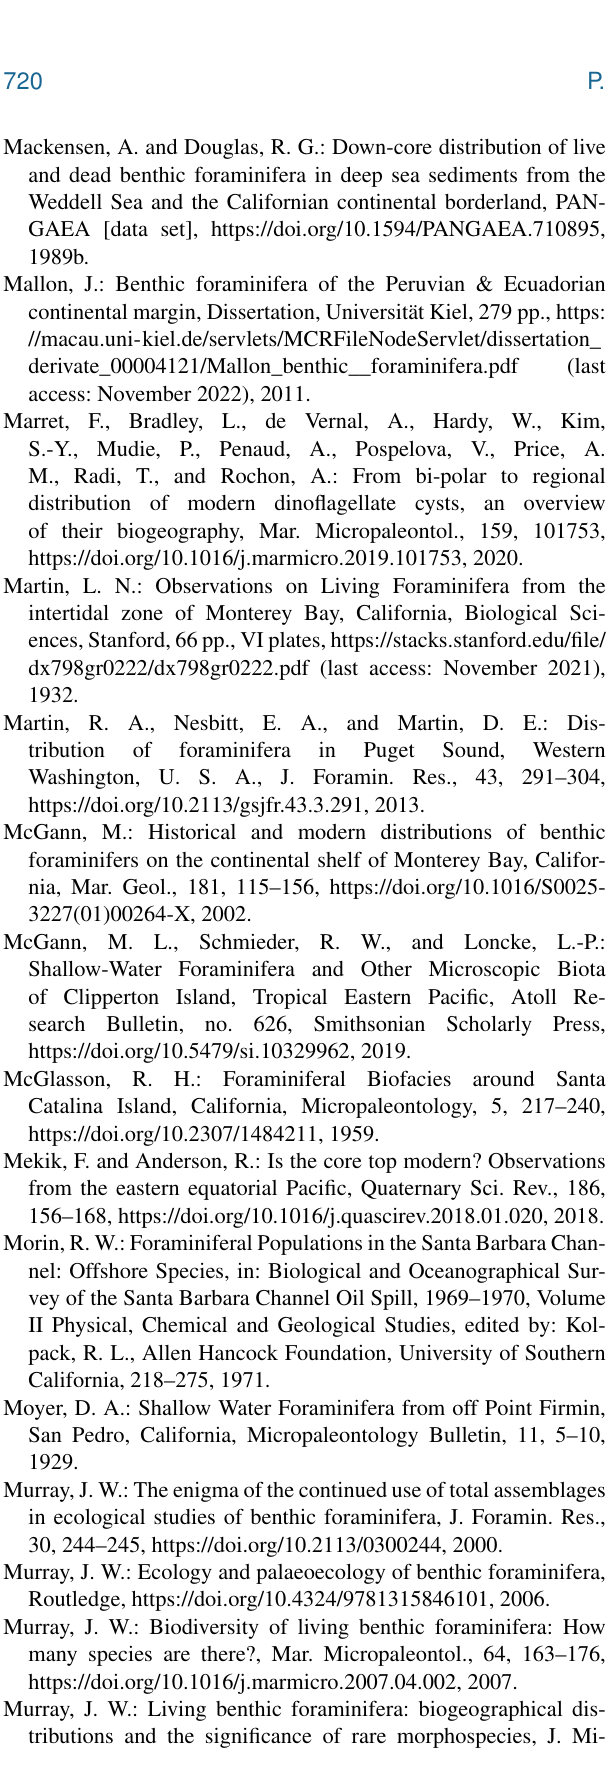
(Table 3) Counts of dead (not stained) benthic foraminifera from stations in the northern Gulf of California, PANGAEA [data